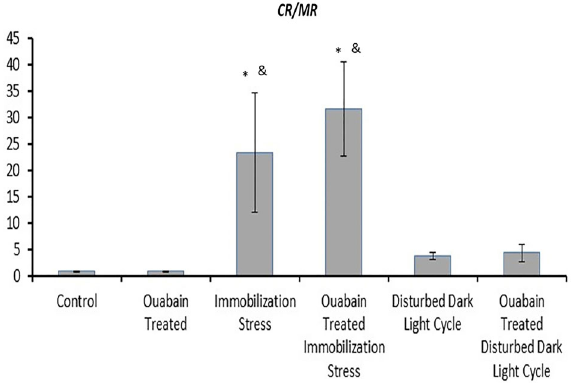
Figure 4. The ratio between relative expressions of hippocampal corticosterone receptors to melatonin receptors ( CR/MR ) to the housekeeping gene beta-actin of the study groups. Data are reported as means ± SD. *P o 0.05 compared to the control group; & P o 0.05 compared to ouabain-treated group